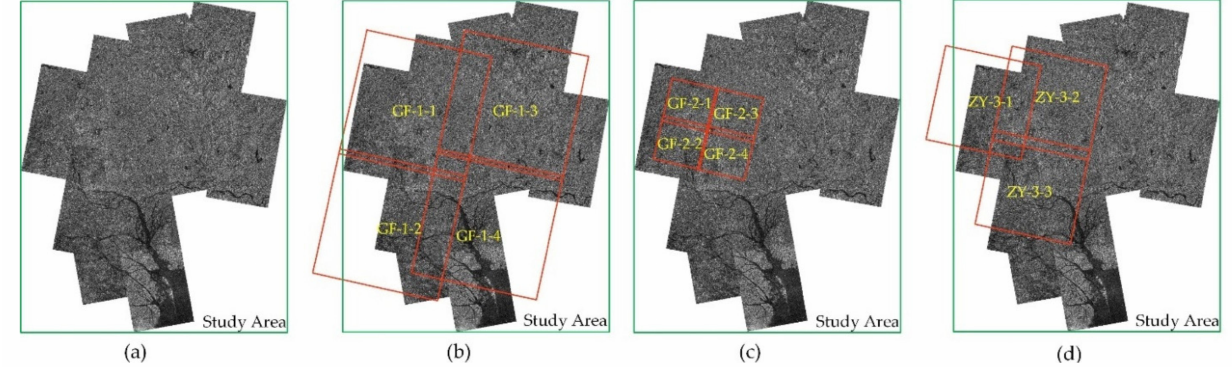
Figure 15. The overlap of optical satellite images with the used SAR reference images. ( a ) The distribution of SAR reference images. ( b – d ) display the overlaps of GF-1, GF-2, and ZY-3 with the SAR reference images, respectively. Note that the number at the end of the name of an image represents a specific image in the corresponding image collection.